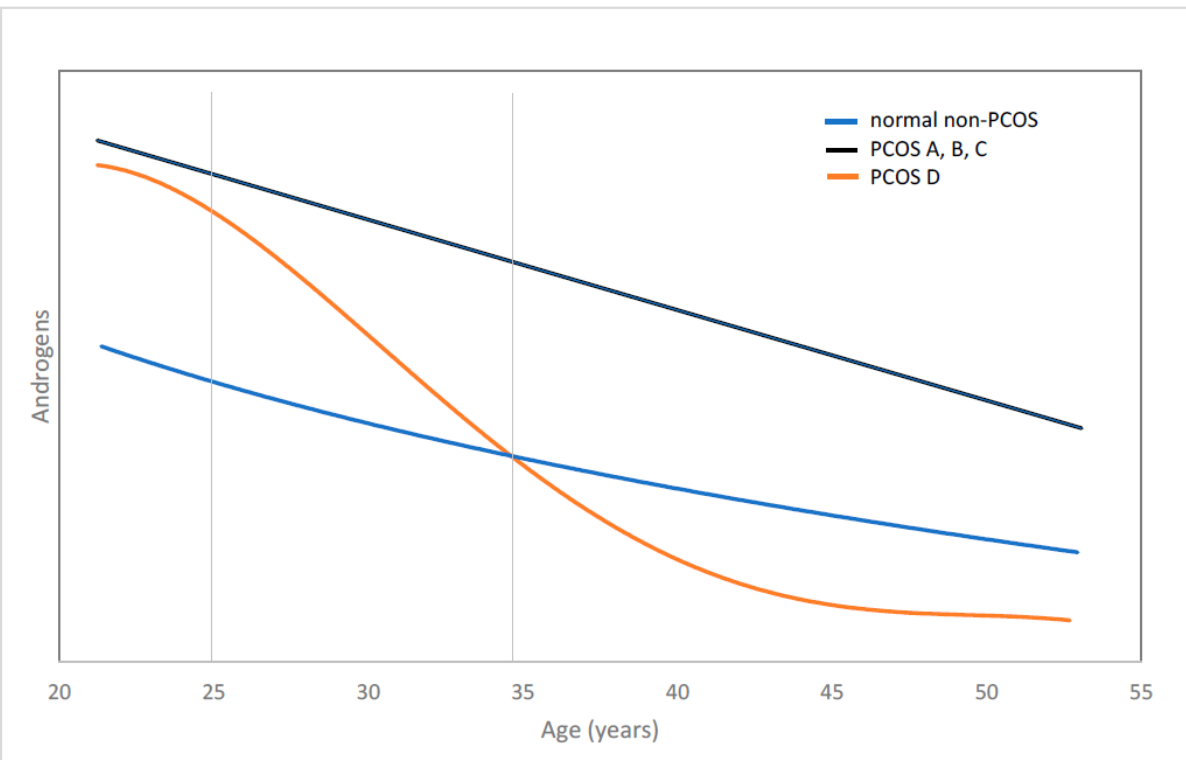
Figure 1. Schematic of androgen decline with advancing age in PCOS and non-PCOS women . The figure demonstrates androgen levels in phenotypes A, B, and C until menopause remain high in comparison to androgens in non-PCOS patients. Phenotype D, however, over approximately 10 years between ages 25–35, goes from hyper- to hypoandrogenism, at which point this phenotype becomes relatively resistant to infertility treatments, a resistance that, as shown in this manuscript, can be reversed through androgen supplementation.